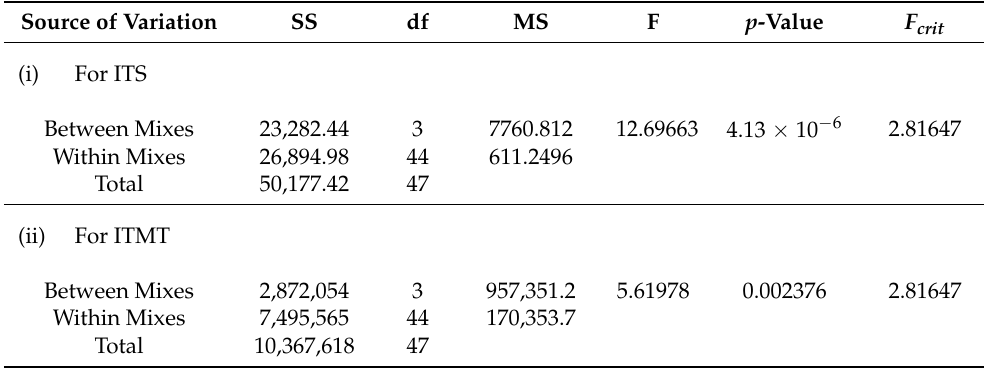
Figure 6. Relation between ( a ) TSR and Strength loss and ( b ) TSR and Stiffness loss. A single-factor ANOVA test ( α = 0.05) was conducted to validate the statistical signif- icance of the variation in the values within the mixtures and between them. The results of the ANOVA tests are provided in Table 3. Based on the analysis, the data for both tests were statistically significant ( F crit < F; p -value < 0.05). So, it is safe to say that ITS and ITMT are good indicators to point towards the moisture damage potential of a mixture. Table 3. Single- Factor ANOVA